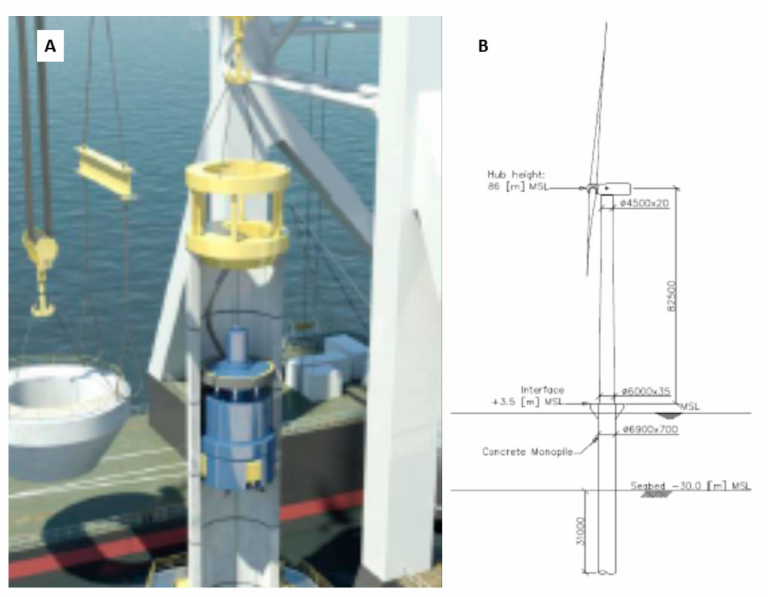
Figure 8. Monopile suction bucket. ( A ) Installation. ( B ) Scheme.